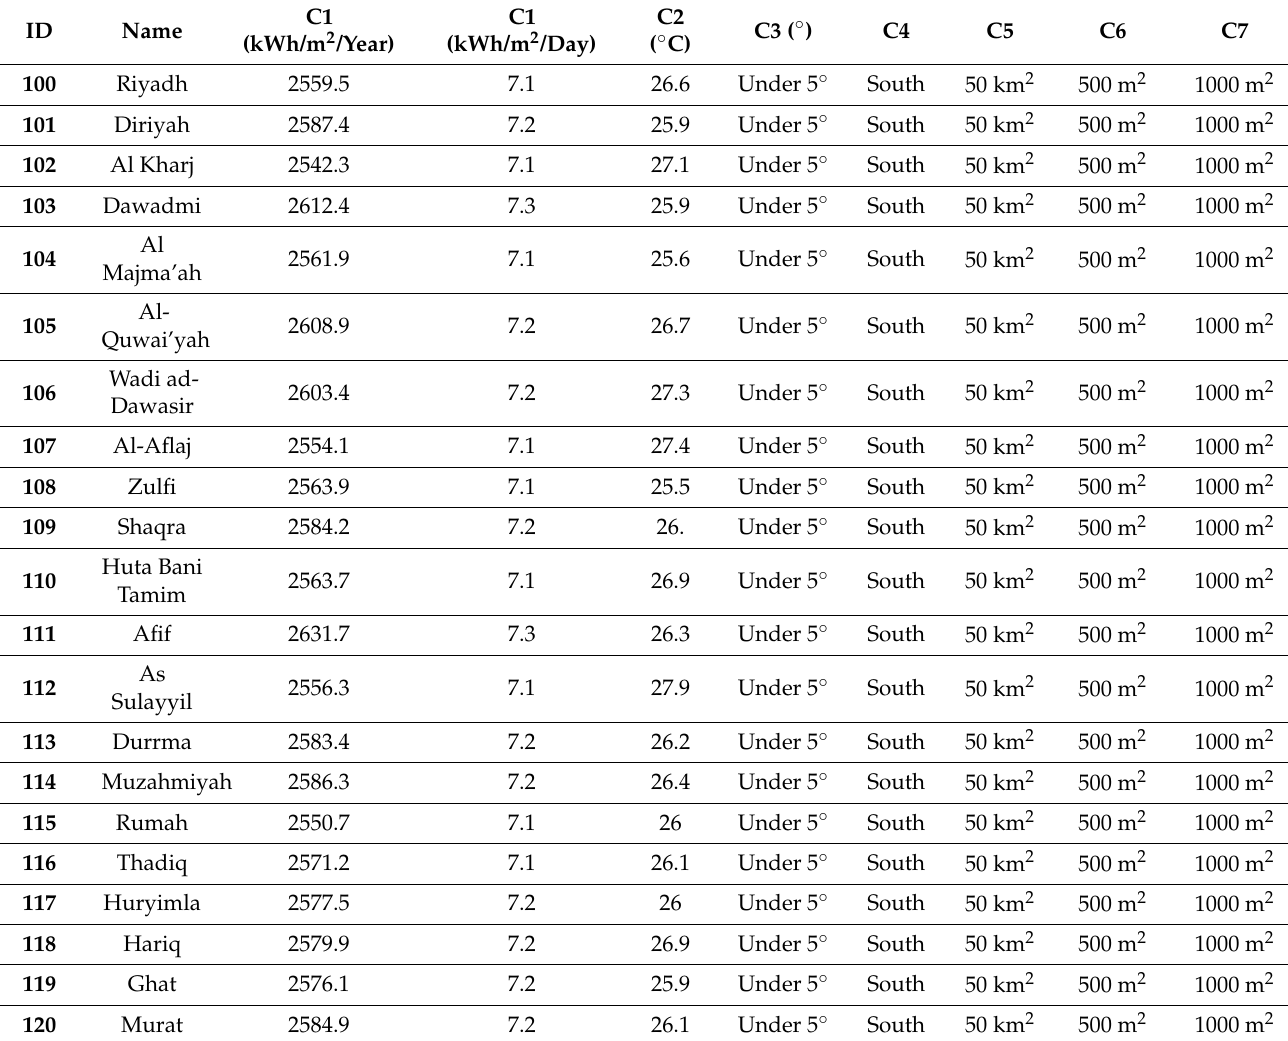
Figure 8. Final GIS criteria weights. Table 10. Average of criteria values for Riyadh